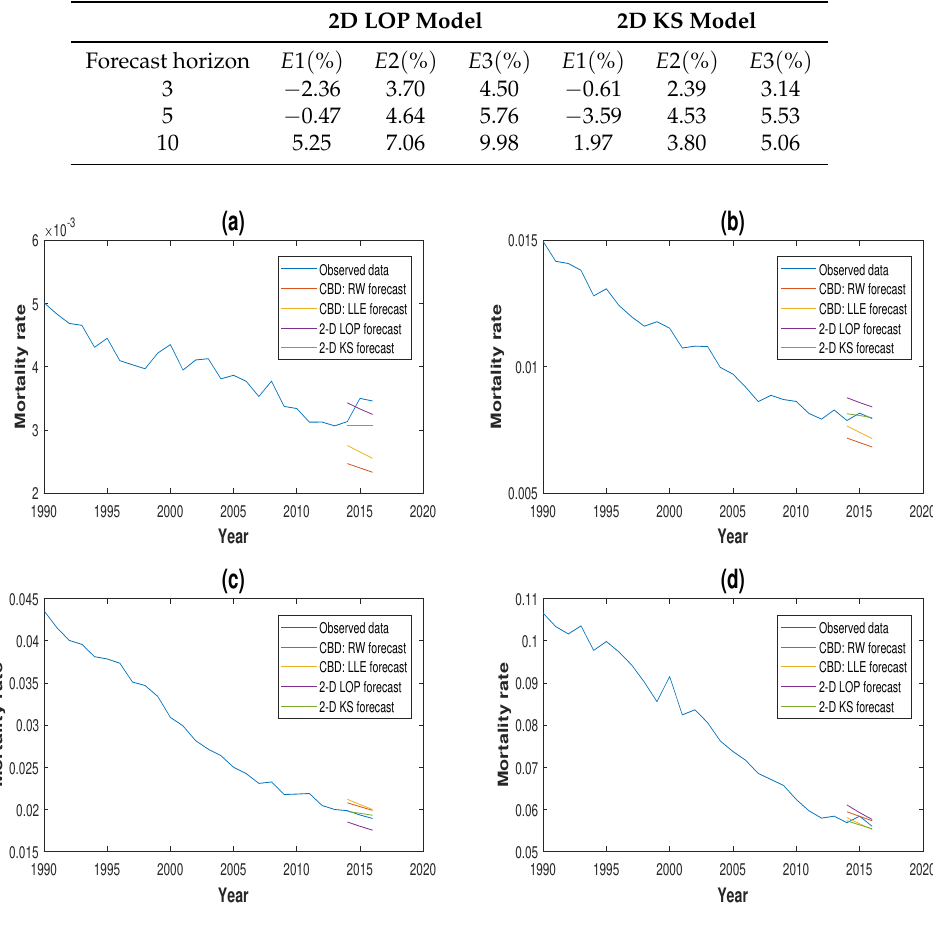
Figure 5. Three-year-ahead forecast from 2014–2016 for GB males aged ( a ) 50, ( b ) 60, ( c ) 70 and ( d ) 80 based on mortality data since